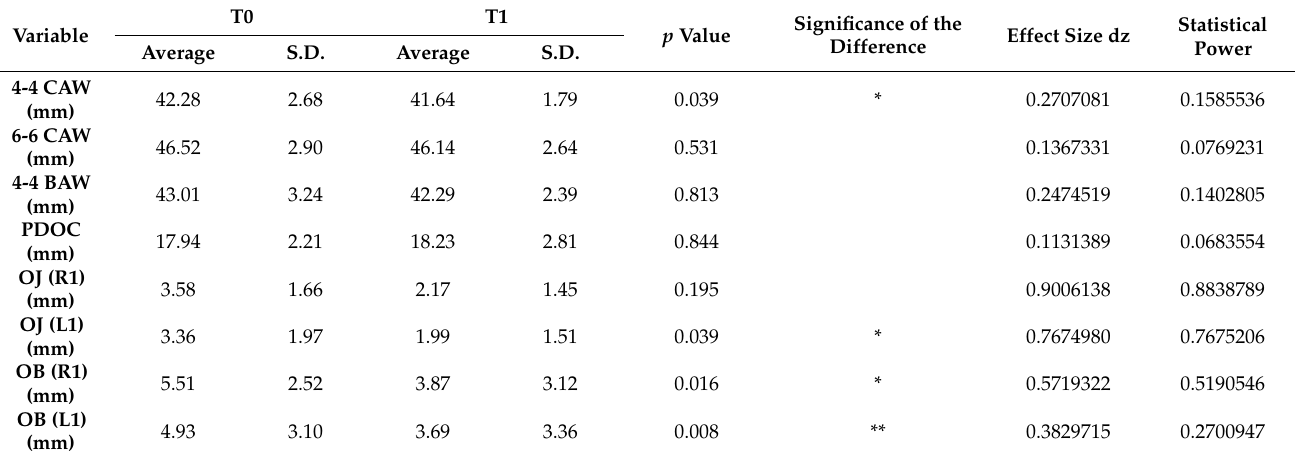
Table 4. Changes in the oral model values before and after using the